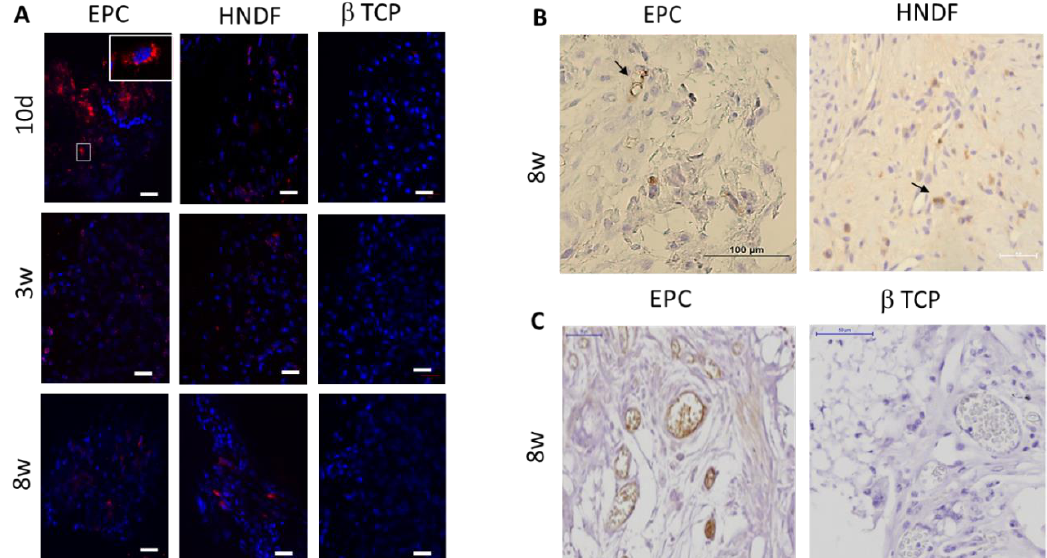
Figure 2. Engraftment of human EPCs in the ectopic transplants. ( A ) Human EPCs and human neonatal dermal fibroblasts (HNDF) were detected in the tissues (red fluorescent), up to eight weeks after transplantation. Scale = 50 μm. ( B ) Immunostaining with human nuclear antigen (HNA) was used to localize human HNDF and EPCs in the tissues (arrow). ( C ) Immunostaining with anti-human CD31 demonstrates integration of EPC into blood vessel walls.